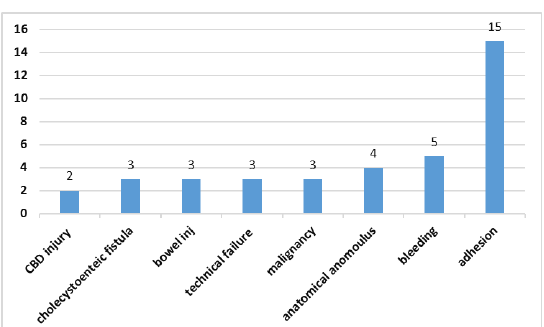
Figure 2: Distribution of laparotomy cholecystectomy according to causes of conversion